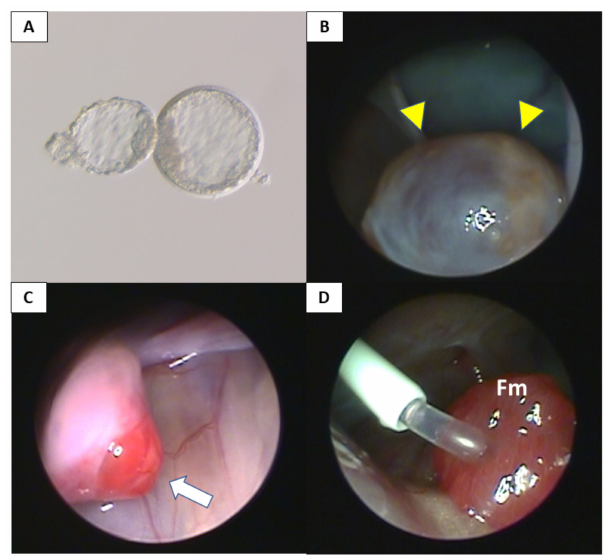
Figure 3. Intracytoplasmicsperminjectionandembryotransfertothegrafteduterus. ( A )Blastocyst-stage embryo for embryo transfer is hatching from zona pellucida. ( B ) Follicular development of ovarian preovulatory follicle (yellow triangles) was observed via laparoscopy. ( C ) Ovulation (white arrow) was confirmed using laparoscopy. ( D ) Embryo intrafallopian transfer was performed after confirmation of ovulation. Embryos were inserted into the fallopian tube through a catheter. Fm, fimbria of